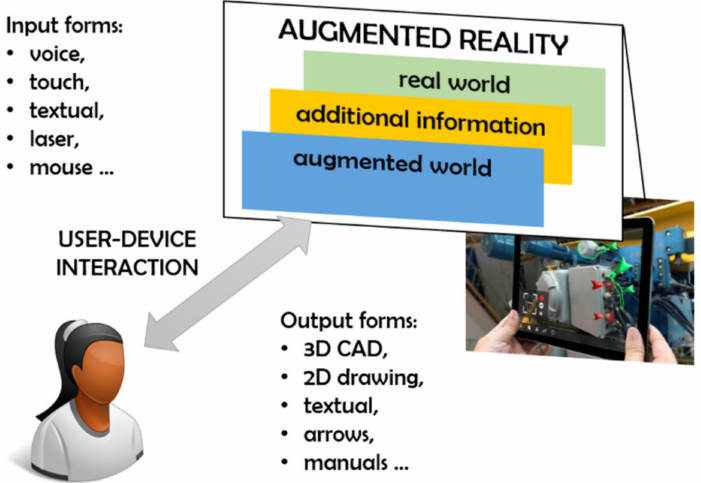
Figure 1. Interaction between user and AR device